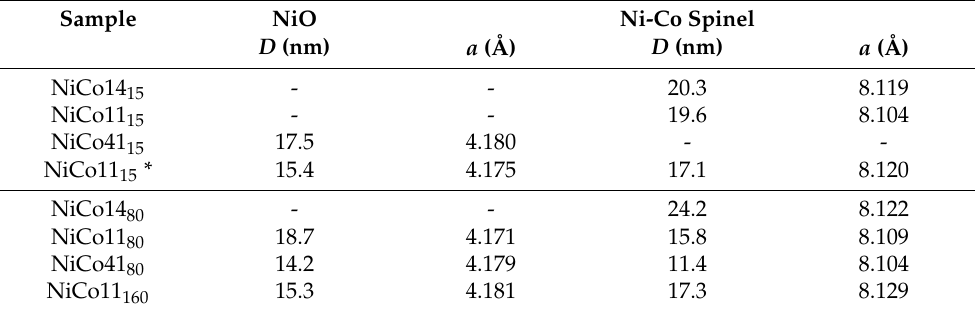
Table 2. Crystallite sizes ( D ) and lattice parameters ( a ) of the NiO-like and Ni-Co spinel-type oxides evaluated according to the powder XRD patterns of the catalysts. The NiCo11 15 * catalyst was prepared with an extended deposition time of 370 min. Sample